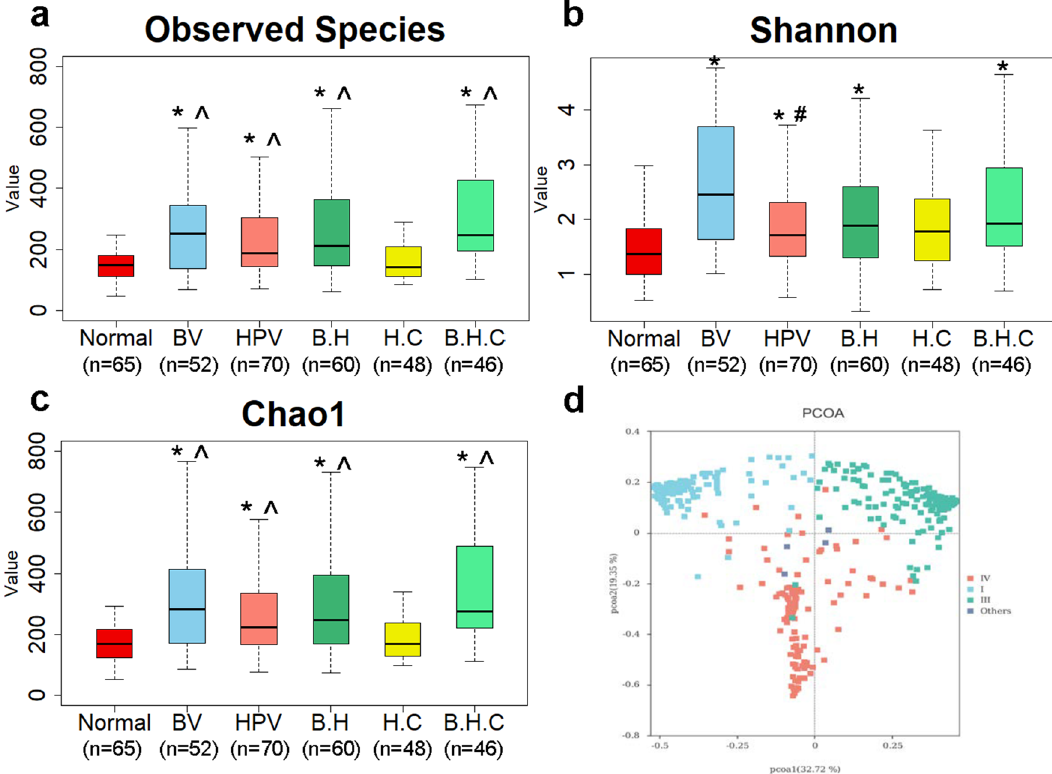
Figure 4. Microbial diversity in 6 groups. ( a ). Observed species indexes of samples in 6 groups. ( b ). Shannon index. ( c ). Chao1 index. ( d ) PCoA based on the Bray–Curtis dissimilarity in CST clusters. Each dot represented a sample of the corresponding group dyed with the same color. I, III, IV represented CST I, III, IV, and others represented samples in CST II and V clusters. BV: BV infected; HPV: HPV infected without CIN; B.H: infected with BV and HPV; H.C: HPV infected with CIN; B.H.C: infected with BV, HPV, and CIN. The P values in a-c were all calculated by the Wilcoxon rank-sum test, alpha value = 0.05. * Significantly different compared with the Normal group. P < .001. ^ Significantly different compared with the H.C group. P < .001. # Significantly different compared with the B.H.C group. P <